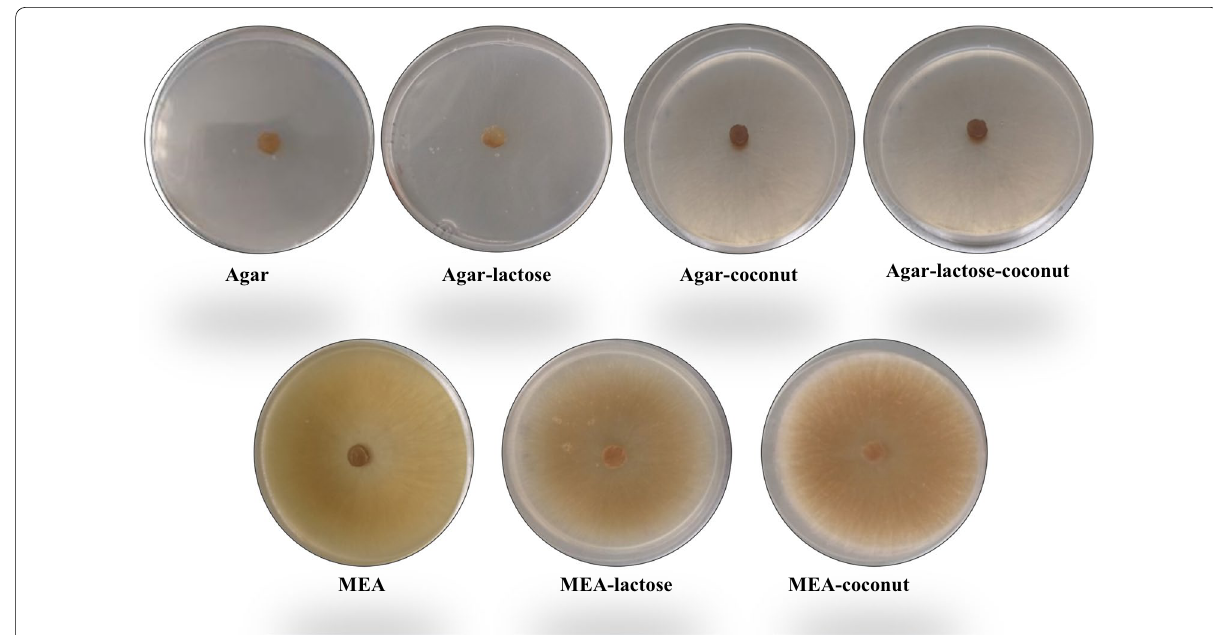
Fig. 2 Morphology of M.esculenta (CDBB‑H‑482) cultured in 90 mm Petri dishes on different culture media. All cultures were photographed ten days after inoculation